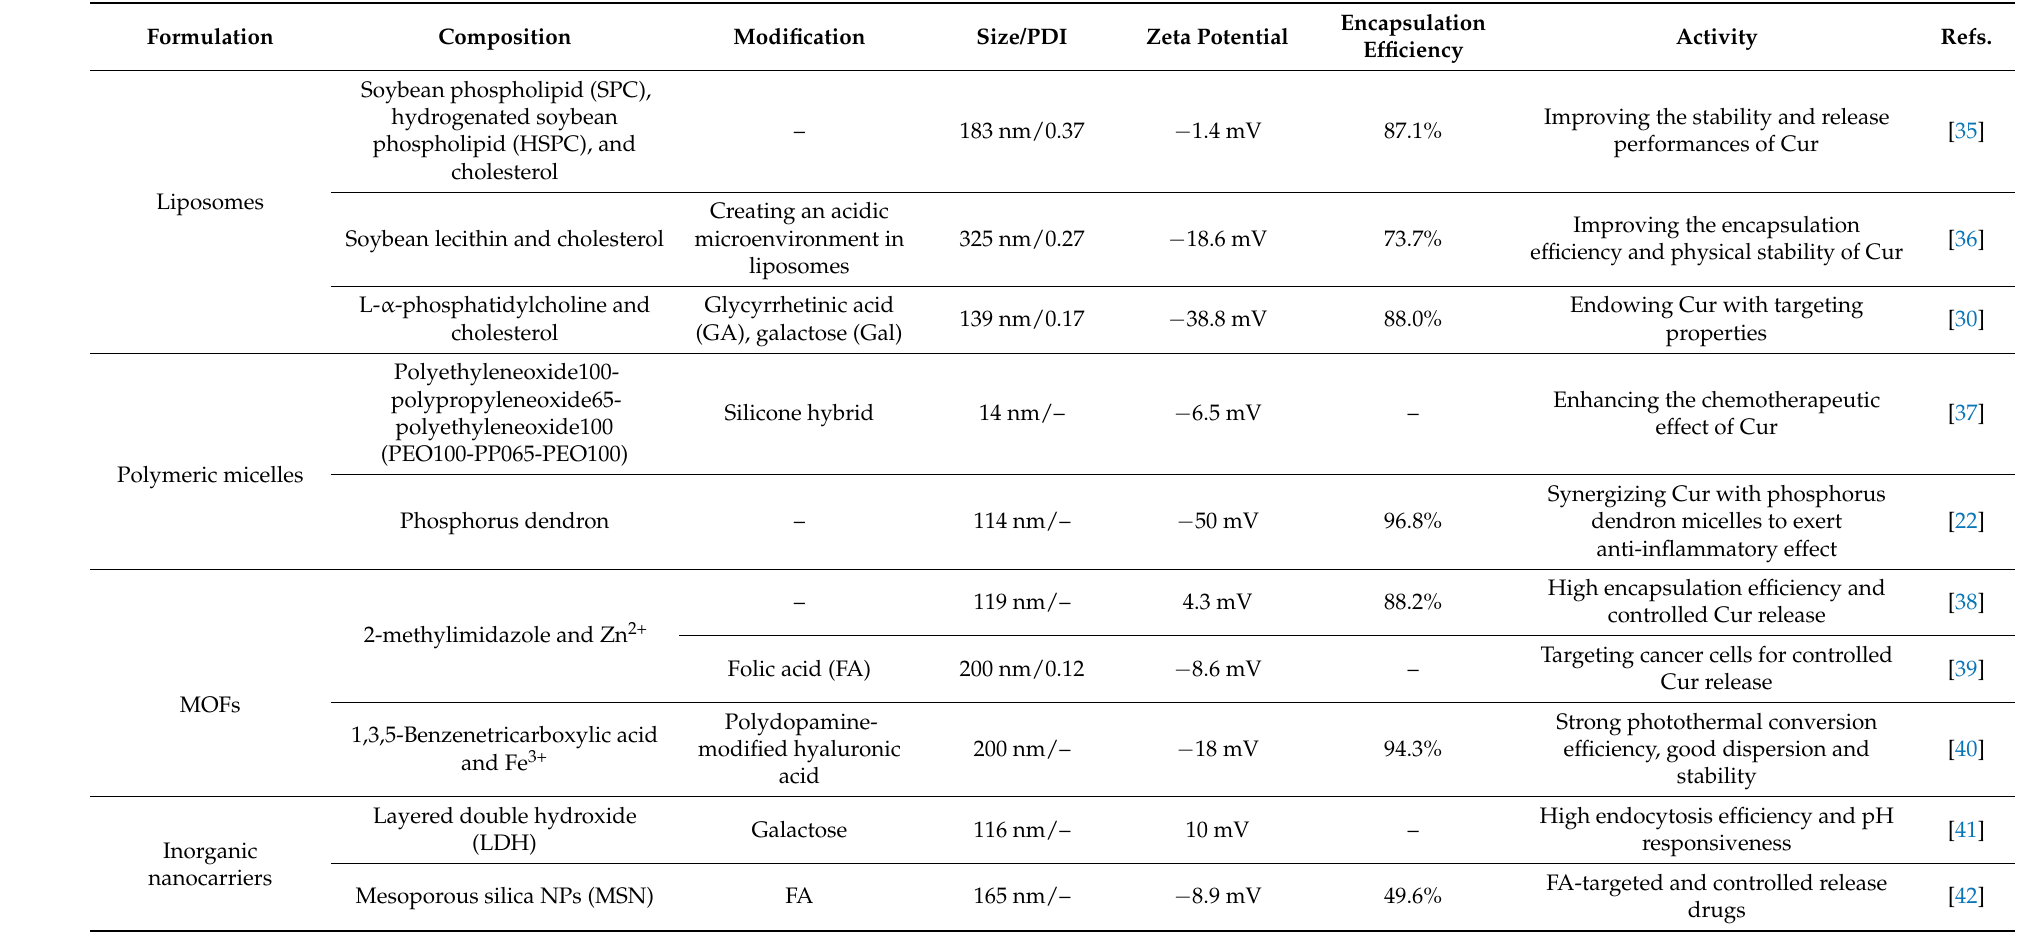
Table 1. Representative types, compositions, physical properties, and functionalization modifications of various Cur